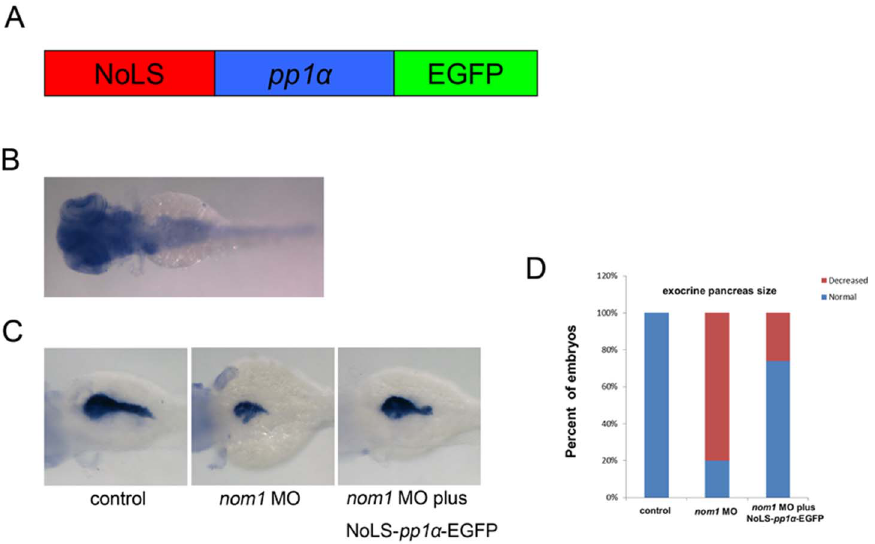
Figure 9. NoLS- pp1 a -EGFP mRNA partially rescues the pancreas defect in nom1 morphant. (A) Schematic diagram of NoLS- pp1 a -EGFP. Red: human nom1 NoLS. Blue: pp1 a coding sequence. Green: EGFP coding sequence. (B) In situ result demonstrates that pp1 a expresses in brain, liver, pancreas and intestine at 3 dpf. (C) Co-injection of NoLS- pp1 a -EGFP mRNA and nom1 MO partially restores try expression as compared to nom1 morphant. (D) The percentage of embryos with relatively normal exocrine pancreas size is statistically higher in nom1 MO and NoLS- pp1 a -EGFP co- injection group.